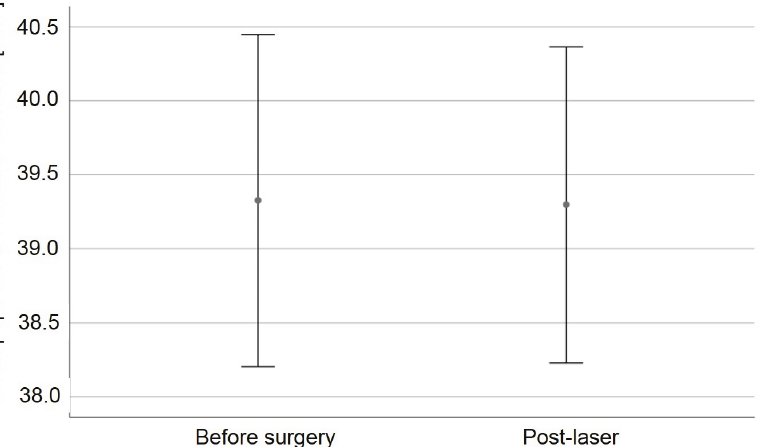
Figure 1. Preoperative and post-laser pupil areas in 40 consecutive and unselected eyes undergoing low-energy femtosecond- laser assisted cataract surgery (FLACS). Error bars showing the means ± standard deviations. Preoperatively, the mean pupil area was 39.33 ± 7.1 mm 2 . Immediately after the completion of laser pretreatment (after suction release), the mean pupil area was 39.3 ± 6.75 mm 2 . A paired t-test revealed no statistically significant changes between the preoperative and post-laser pupil areas ( P = 0.93, 95% CI: -0.71 to